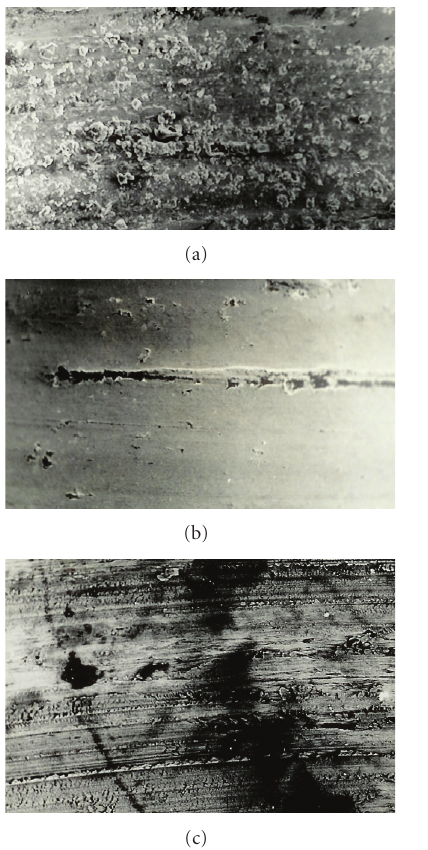
Figure 1: Scanning electron micrographs. (a) Grease A at 140kgf, (b) Grease B at 280 kgf, (c) Grease C at 280 kgf.